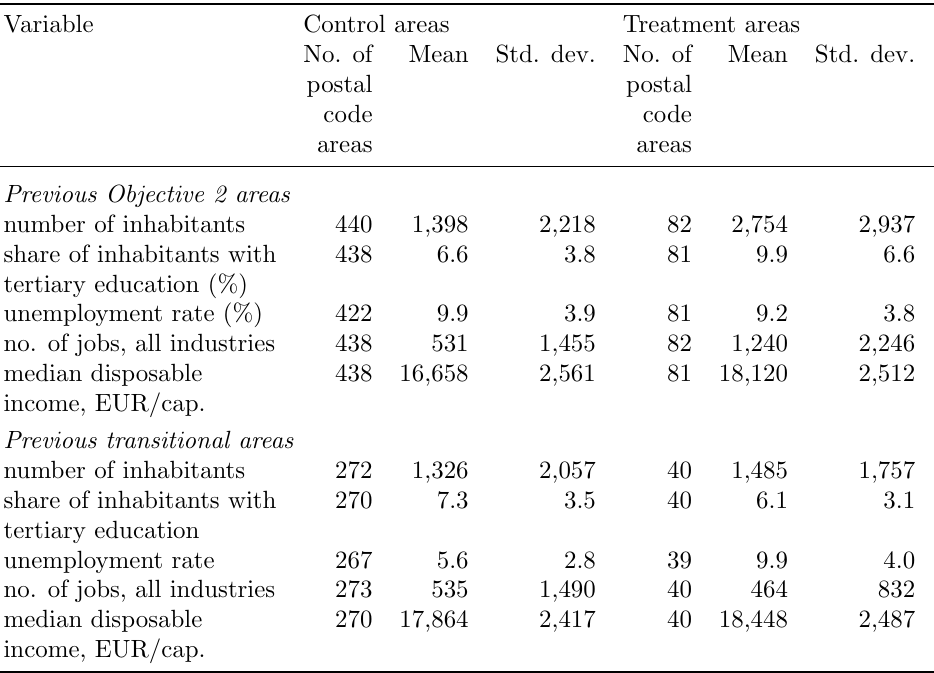
Table 2: Descriptive statistics of the study areas in 2007 Variable Control areas Treatment areas